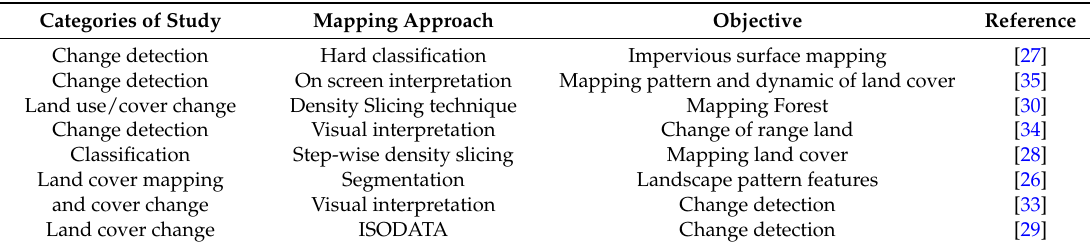
Table 1. Selected studies, using CORONA imagery, that illustrate the variety of conventional techniques used to the identify spatial distribution of land